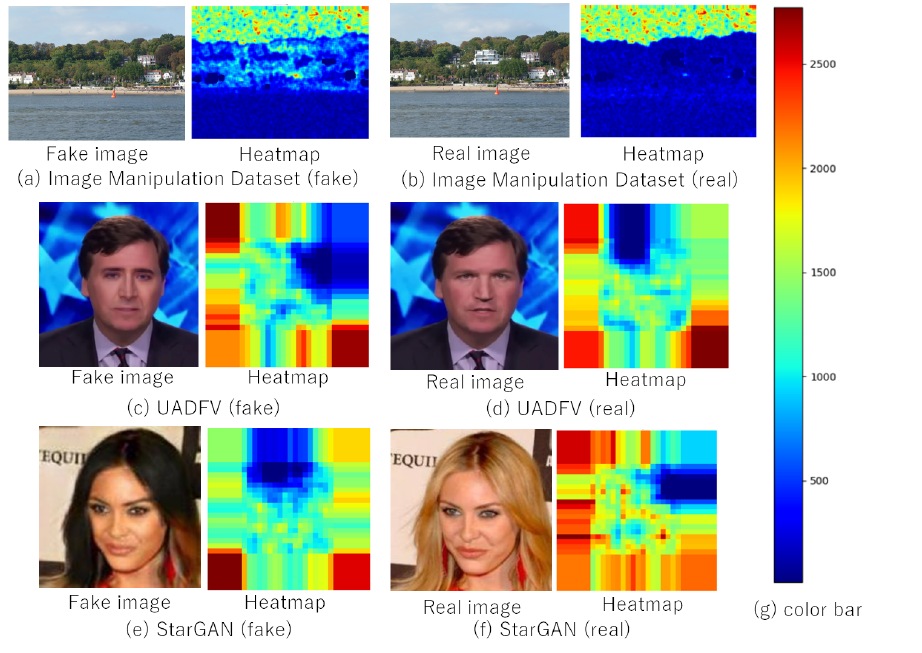
Figure 8. The robustness of the noiseprint algorithm no additional operation. ( a ) Image Manipulation Dataset (fake); ( b ) Image Manipulation Dataset (real); ( c ) UADFV (fake); ( d ) UADFV (real); ( e ) StarGAN (fake); ( f ) StarGAN (real); ( g ) Color